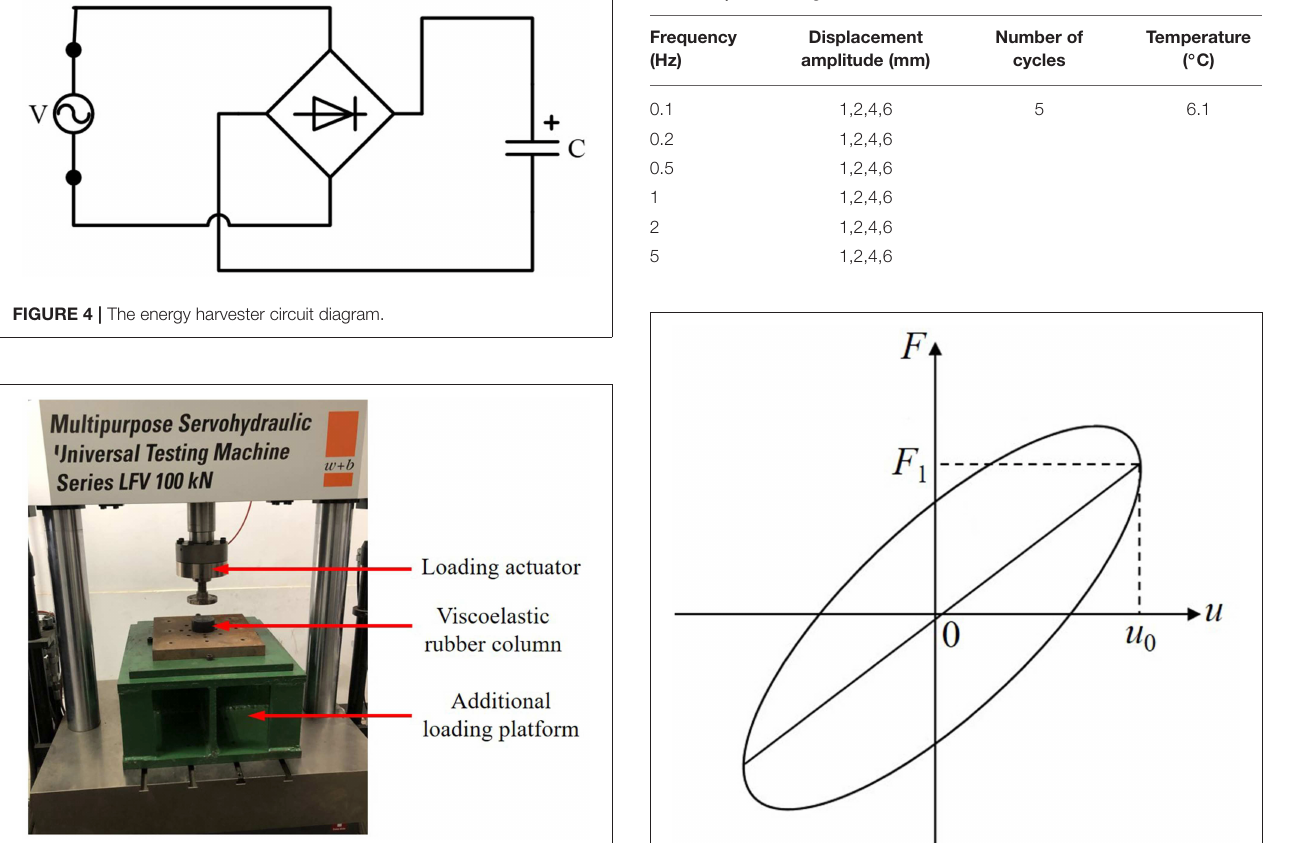
TABLE 1 | The loading iconditions of the test.